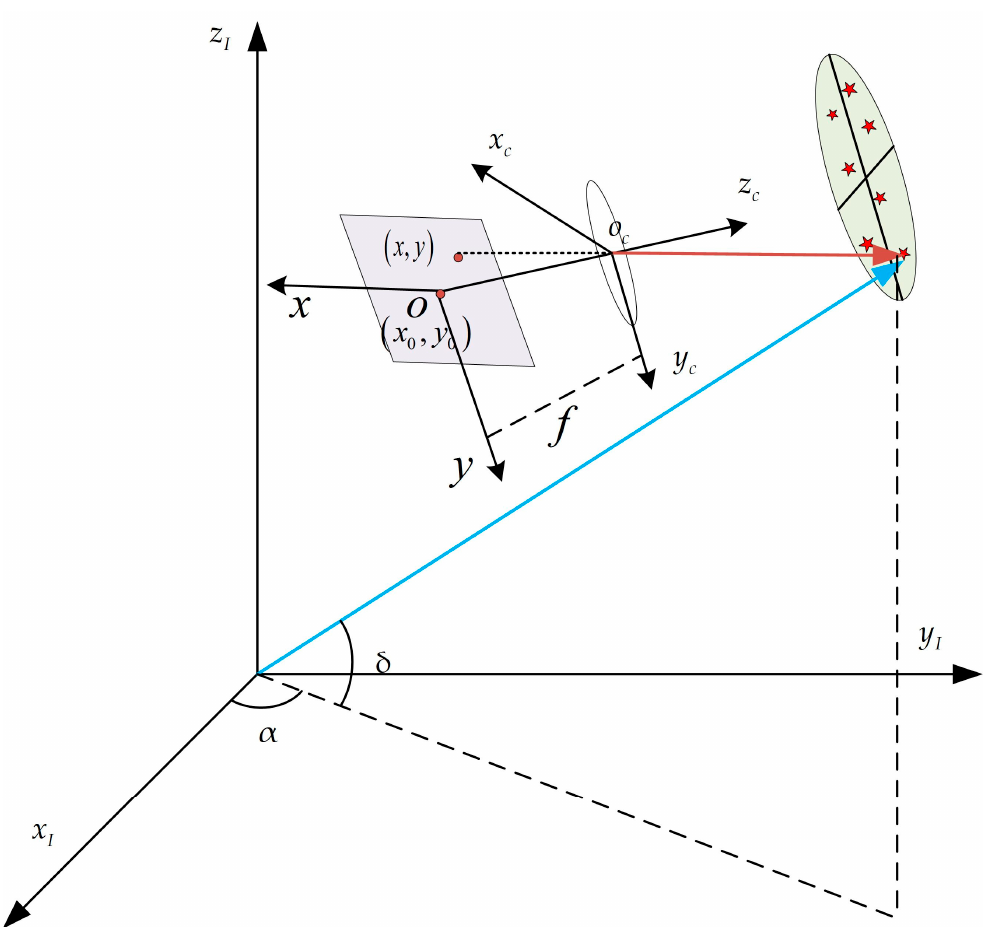
Figure 5. Schematic diagram of the star tracker imaging process.